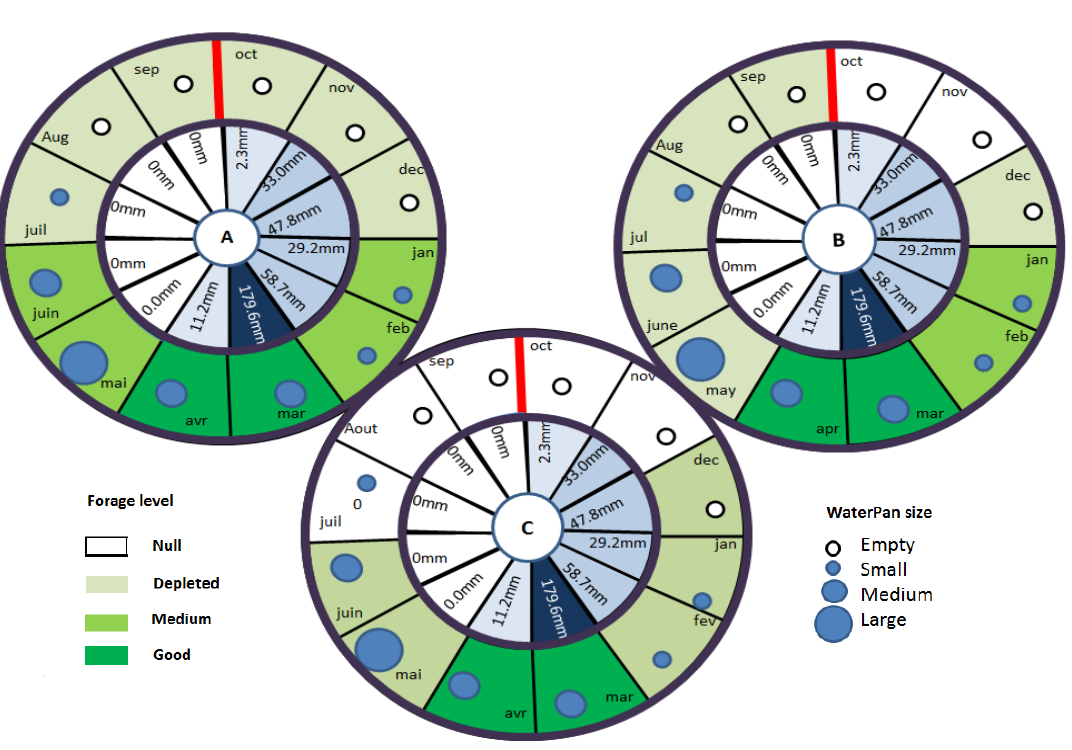
Figure 12. A representation of the tabulated function controlling the forage level of grazing areas and the size of water pans for the “Bad Rain” year. The three diagrams represent the forage level at the end of each month in a given grazing area according to the number of cows grazing during the month. A: no cow grazing; B: between 1 and 10 cows; C: more than 10 cows. The circles in each month represent the size of water pans. Monthly rainfall is given on the inner